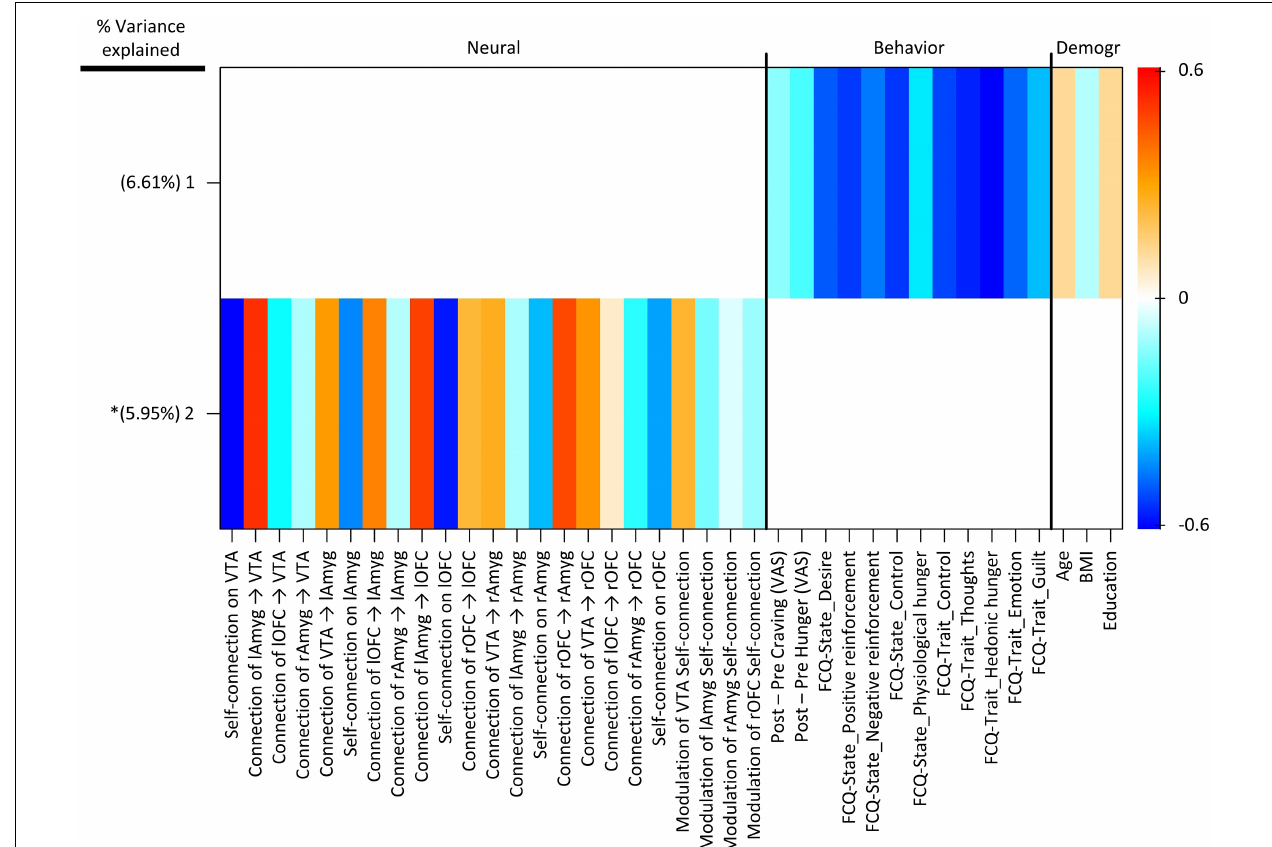
FIGURE 5 | Group factor analysis (GFA) robust factor loadings. Heatmap colors indicate the weight of each group variable loading. Robust group factors are sorted in descending order by mean percent variance explained across all groups. Asterisks indicate latent variable that contained at least one latent variable loading whose 95% credible interval did not contain 0. Latent variable labels, indicating the variable group onto which each latent variable was loaded and the order by most variance explained, are given in the upper key beneath the heatmap. BMI, Body Mass Index; Demogr, Demographic; FCQ-State, Food Craving Questionnaire-State; FCQ-Trait, Food Craving Questionnaire-Trait; lAmyg, Left Amygdala; lOFC, Left Orbitofrontal Cortex; rAmyg, Right Amygdala; rOFC, Right Orbitofrontal Cortex; VTA, Ventral Tegmental